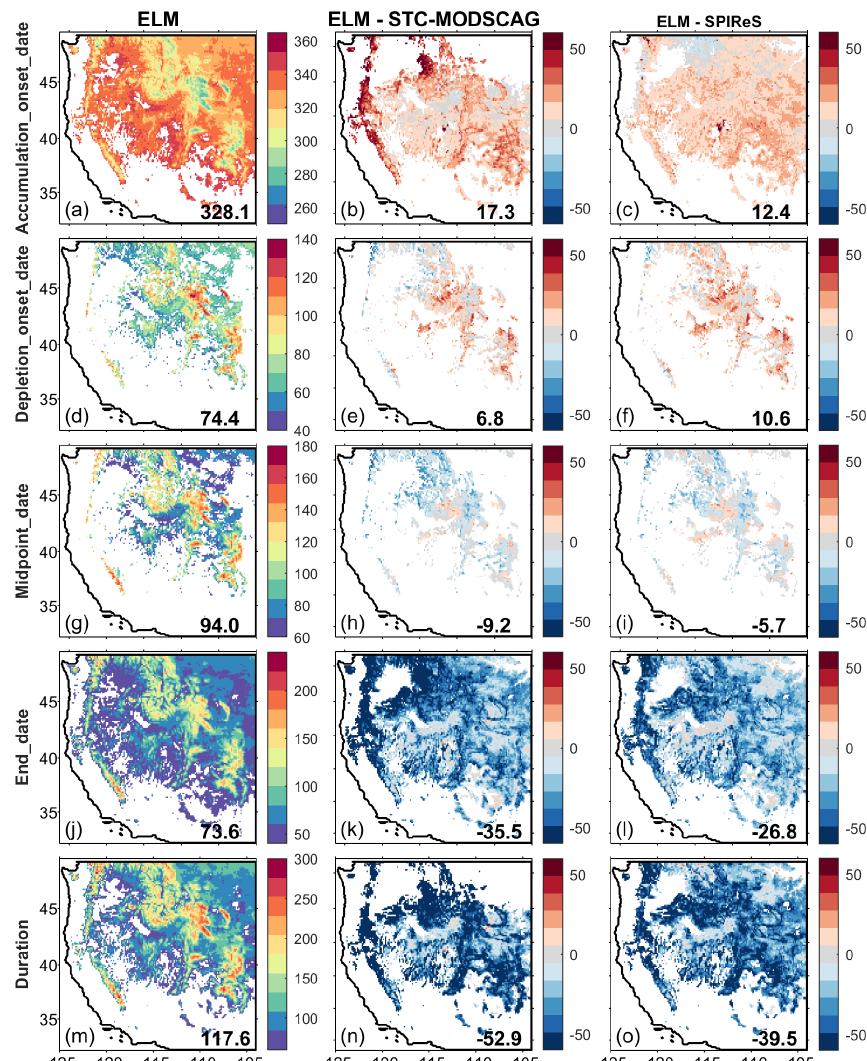
Figure 15. Spatial distributions of (a, d, g, j, m) snow timing, and (b–c, e, f, h, i, k, l, n–o) the snow timing difference between ELM and two remote sensing products (i.e., STC-MODSCAG and SPIReS). Five snow timing metrics are included: (a–c) Accumulation_onset_date, (d–f) Depletion_onset_date, (g–i) Midpoint_date, (j–l) End_date, and (m–o) Duration. The regions with no successful retrievals of snow timing are masked with white color. The area-weighted average values are labeled in each